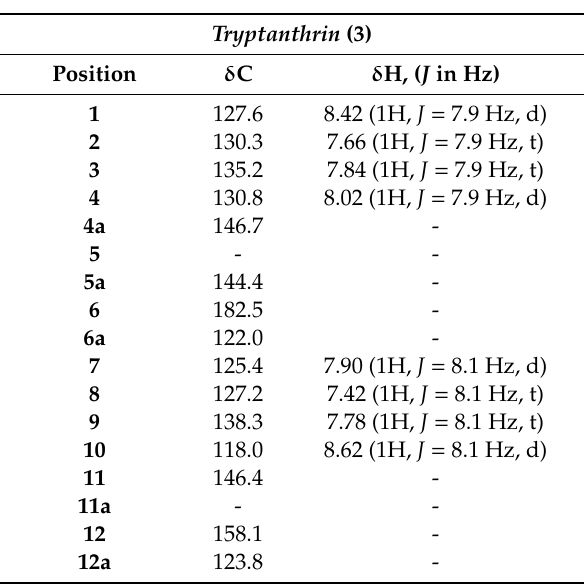
Table 2. H and 13 C NMR data for compound 3 in this